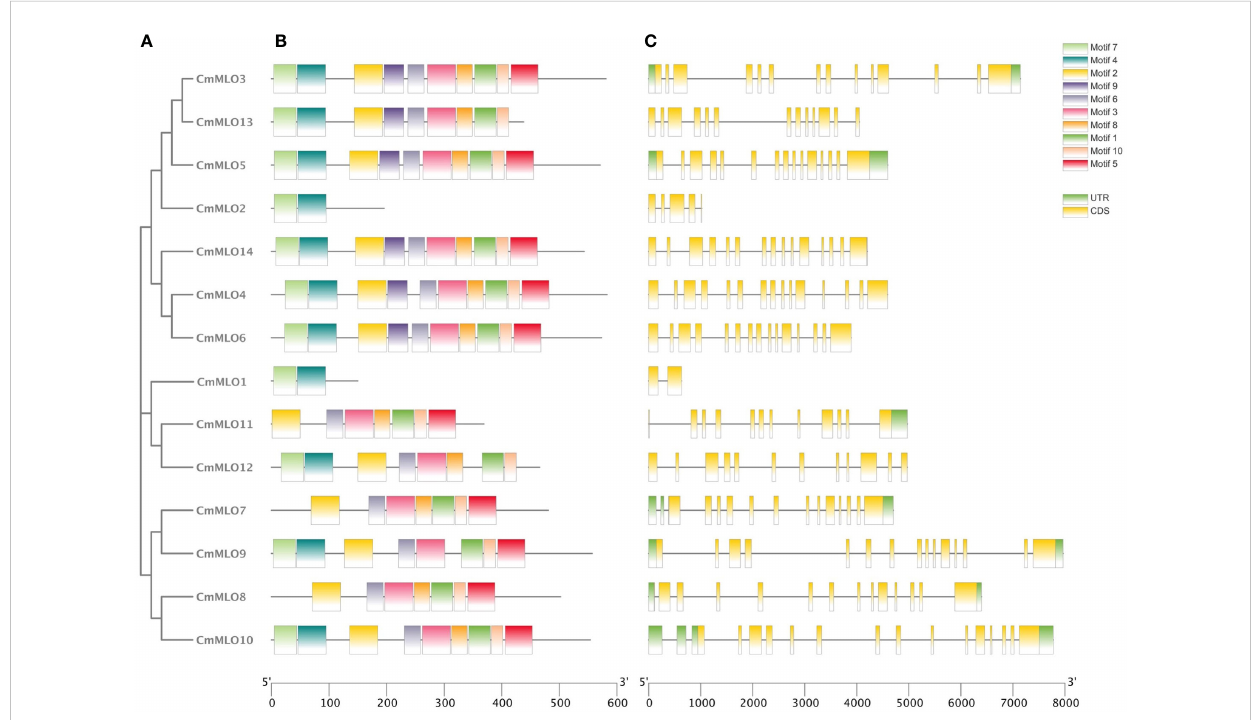
FIGURE 2 Analysis of conserved motif and gene structure of the CmMLO gene family. (A) phylogenetic tree of the CmMLO gene family, (B) CmMLO gene motif, (C) CmMLO gene